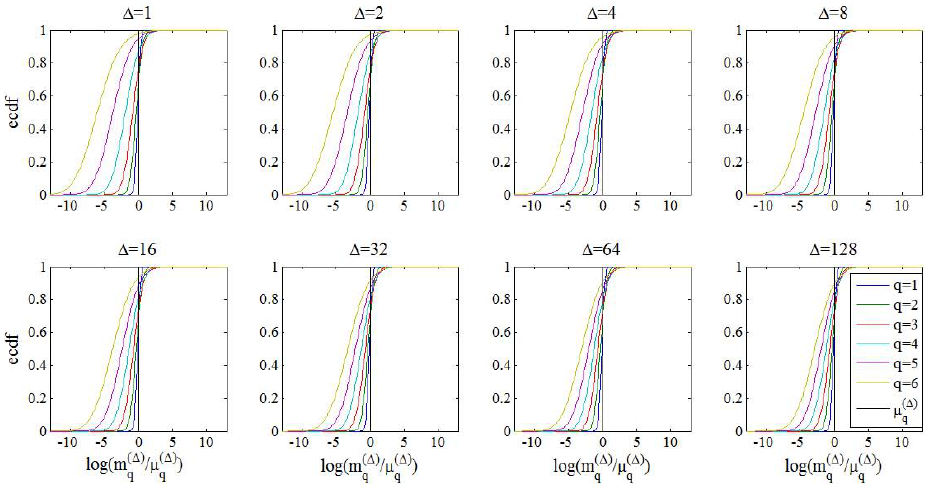
Fig. 3. Empirical cumulative distribution function (ecdf) of the natural logarithm of the ratio of q th moment estimates to their expected values ) q ] = µ (1) q when varying 1 . E[( x (1) j